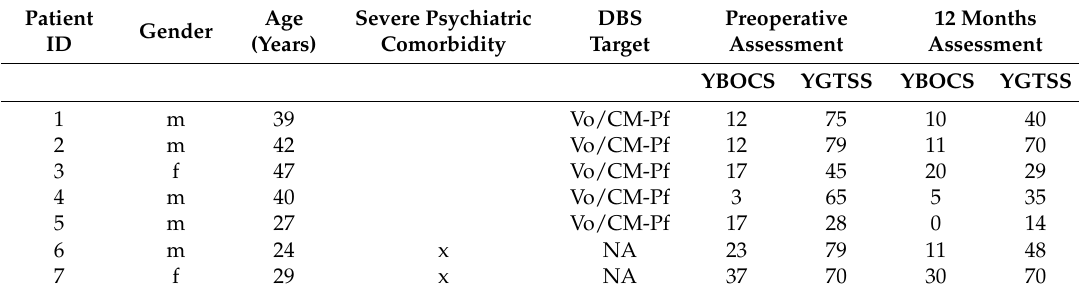
Table 1. Demographic and deep brain stimulation (DBS) details for the patients recorded during the acute